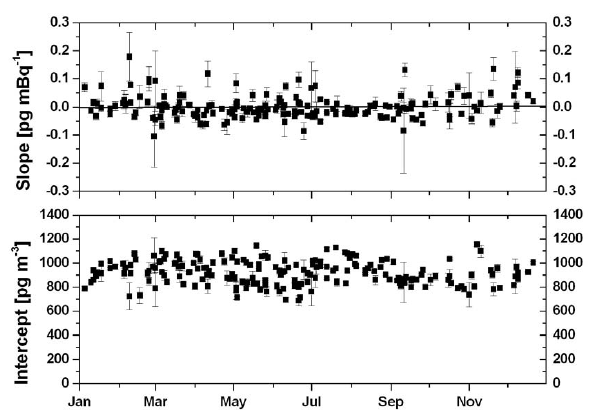
Fig. 3. Seasonal variation of the GEM/ 222 Rn slopes (upper panel) Fig. 3: Seasonal variation of the GEM/ 222 Rn slopes (upper panel) and the intercepts and the intercepts (bottom panel). (bottom panel).